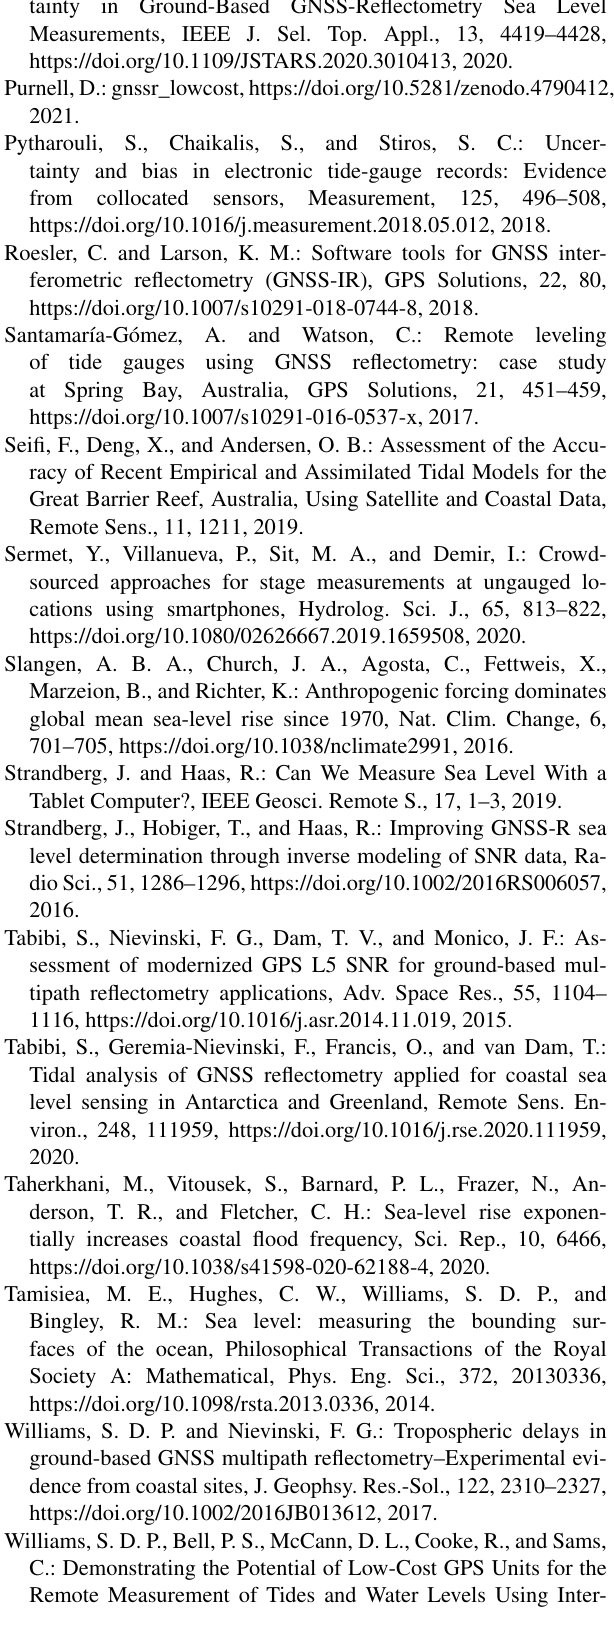
C.: Demonstrating the Potential of Low-Cost GPS Units for the Remote Measurement of Tides and Water Levels Using